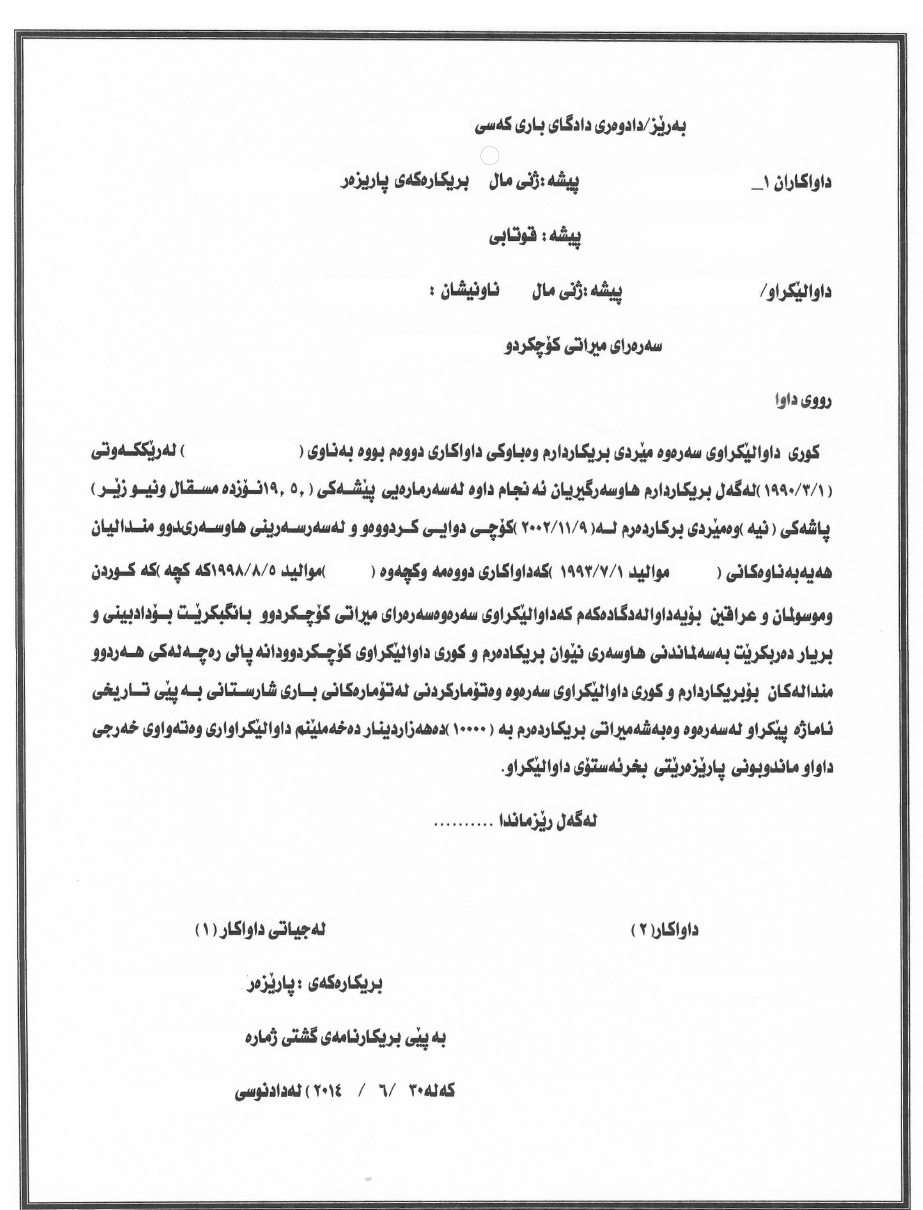
Figure 11. Court document image for evaluation by final model